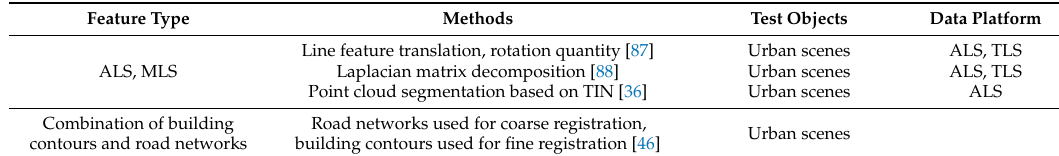
Table 3. Line-based registration methods for point clouds.